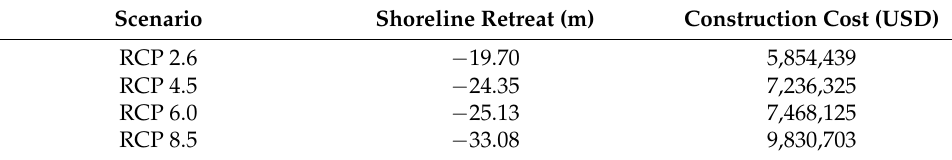
Table 6. Beach nourishment construction cost of Pattaya beach.